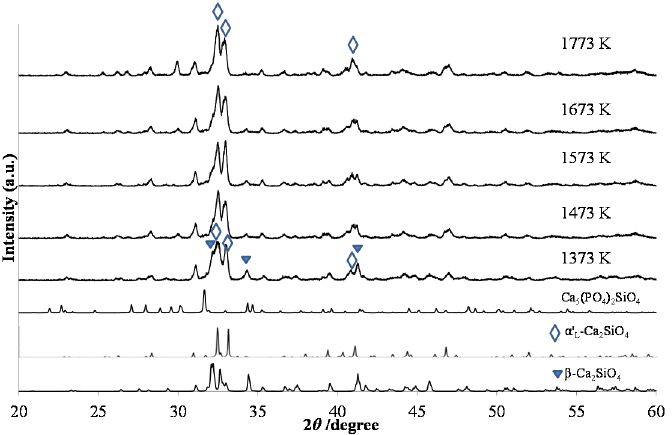
Figure 4. XRD patterns of (Ca 1.95 Eu 2+0.02 □ 0.03 )(Si 0.94 P 0.06 )O 4 annealed at various temperatures from 1373 K to 1773 and subsequent heating under 97% Ar–3% H 2 .